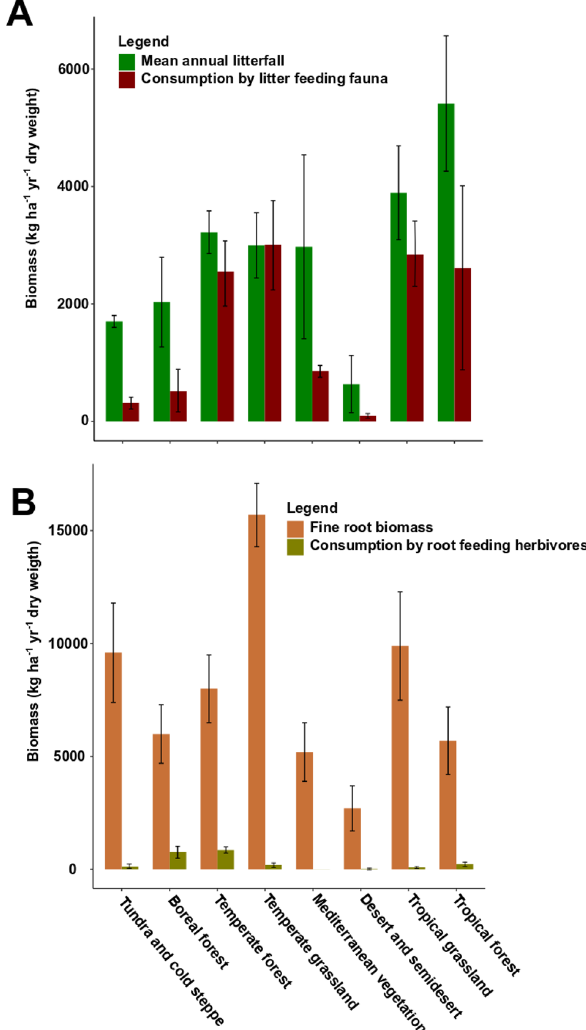
Figure 5. Mean annual litterfall and estimated consumption of litterfall by soil fauna across biomes ( A ) and estimated quantity of belowground living fine roots consumed by belowground herbivores across biomes ( B ). Values for annual litterfall in ( A ) and fine root biomass ( B ) are means ±